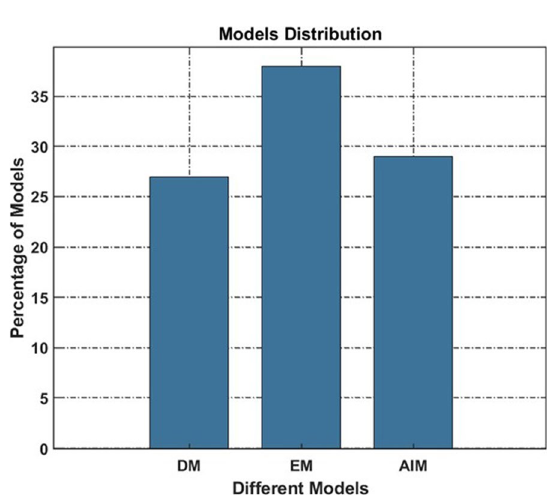
Fig. 2 Article distributions based on digital databases Fig. 3 Distributions of manuscripts based on traditional and